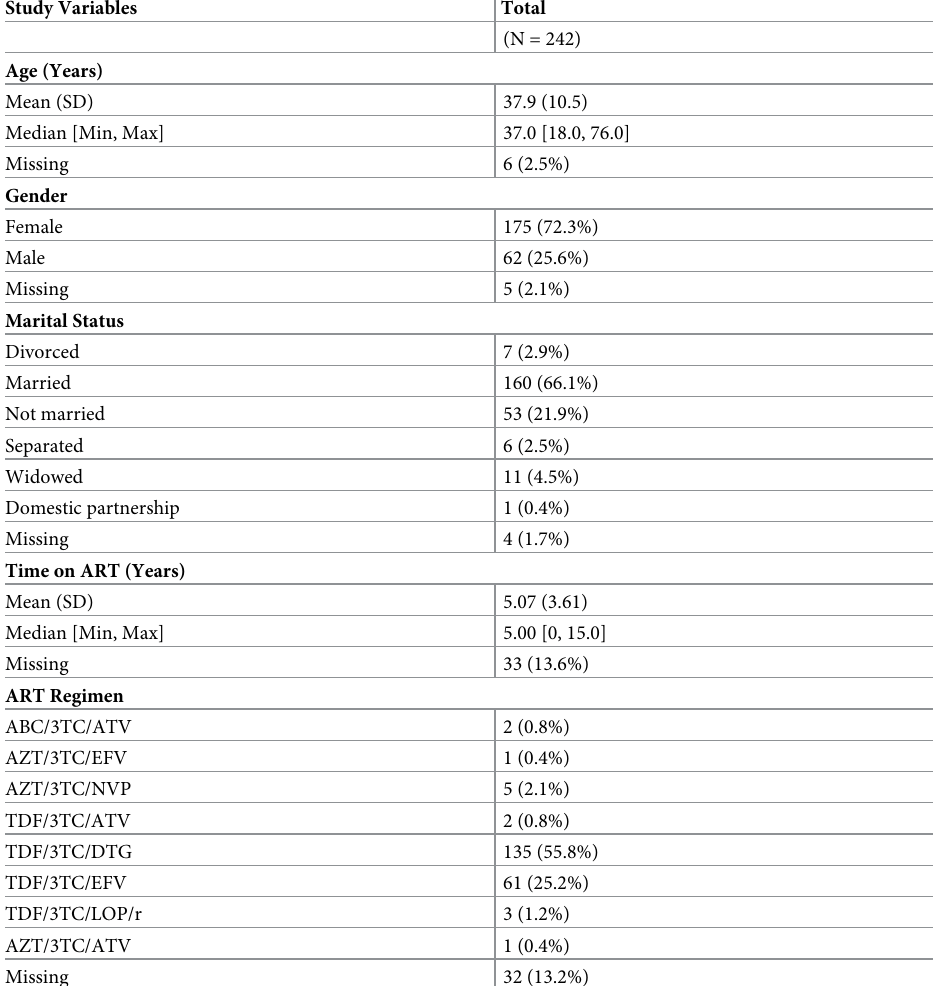
Table 1. Demographic and clinical characteristics of the study